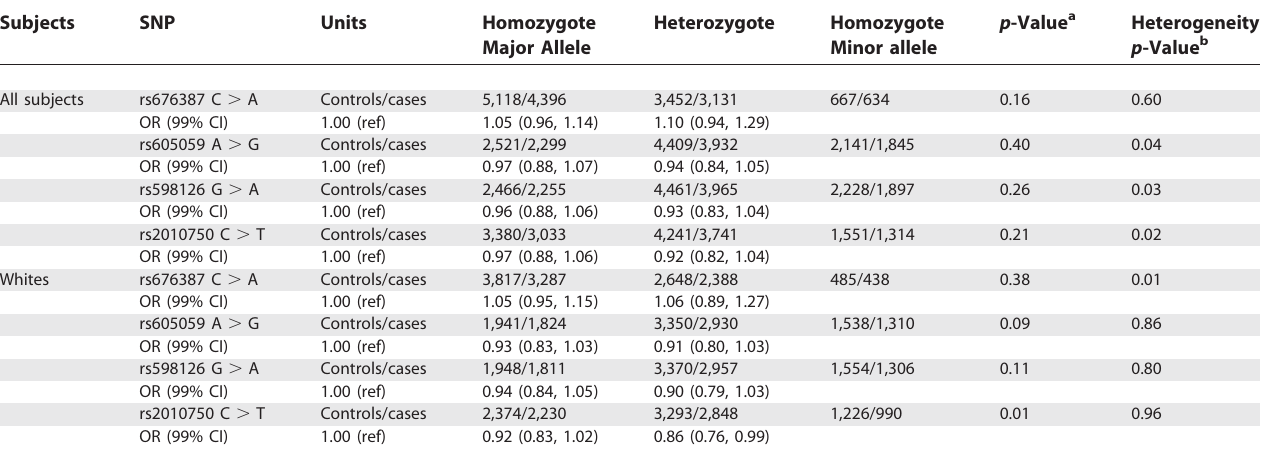
Table 5. HSD17B1 htSNPs and Prostate Cancer Risk,